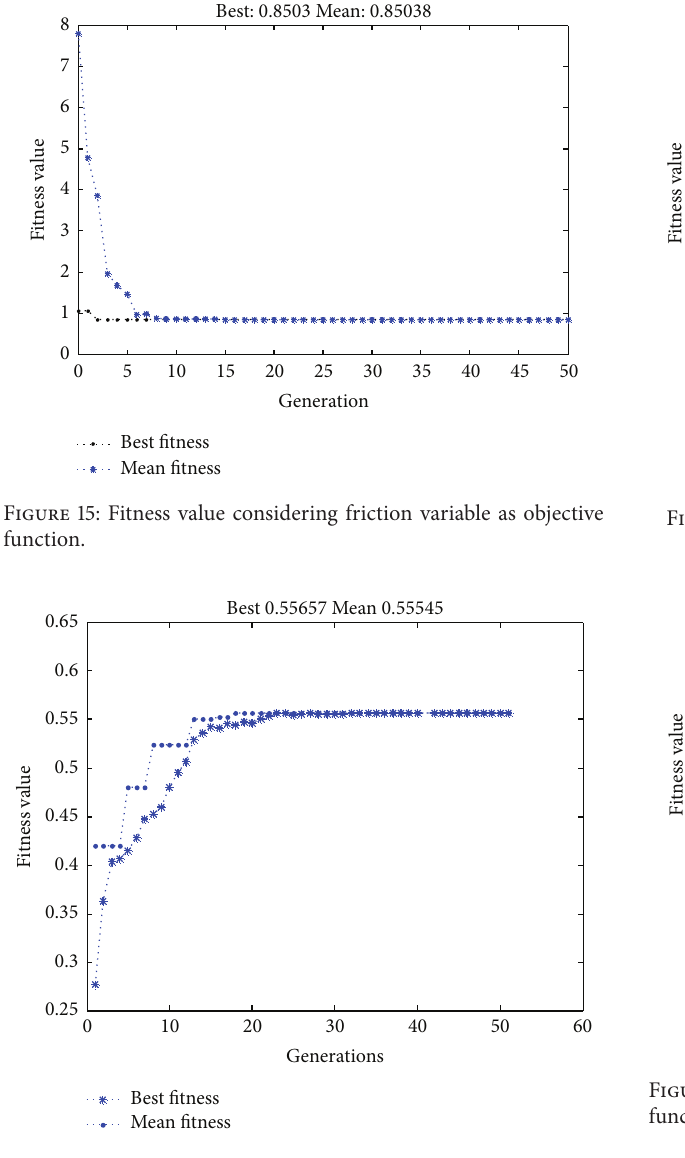
Figure 16: Fitness value considering flow as objective function.